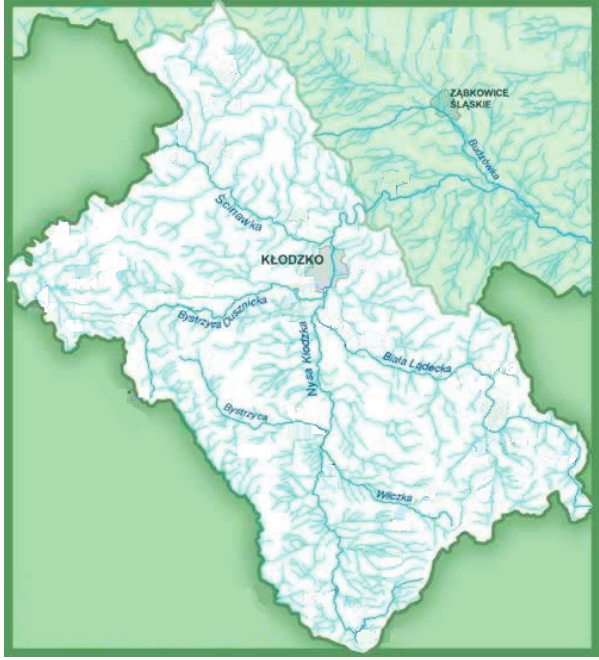
Fig. 1b. The catchment area of the river of Nysa Kłodzka (SW part of Poland); Characteristics of the balance sheet catchment area of the river Nysa Kłodzka, according to Jerzy